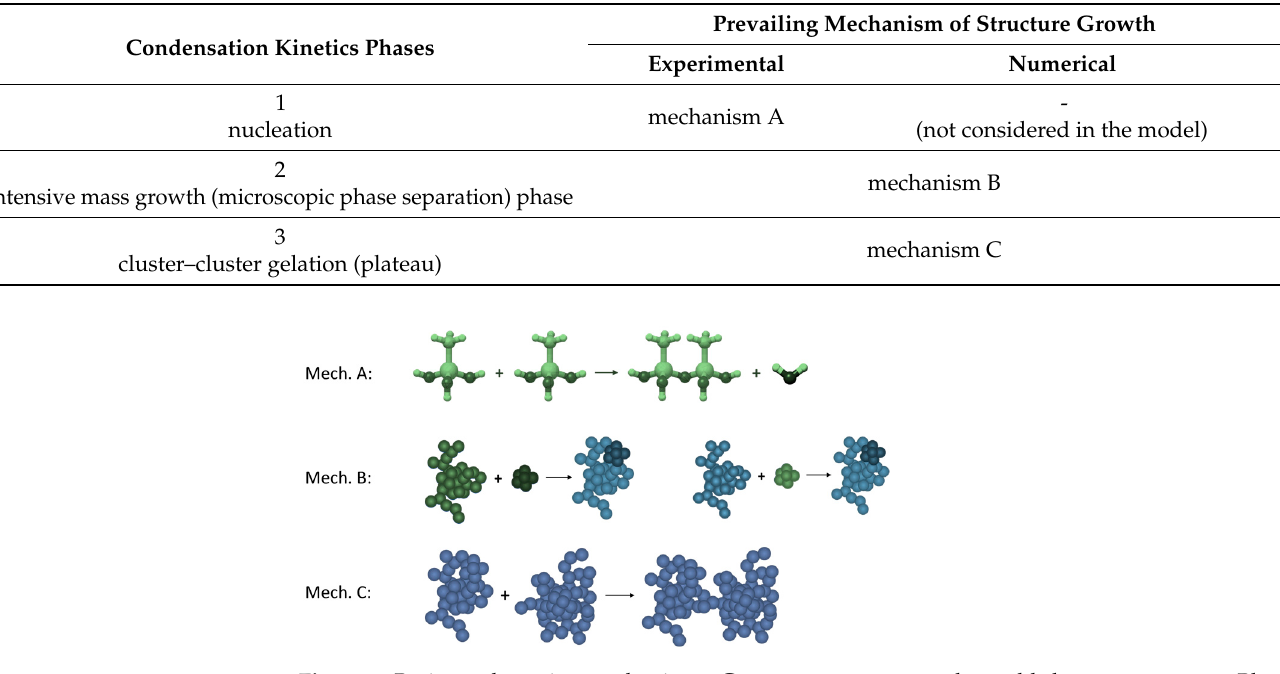
Figure 5. Basic condensation mechanisms. Green structures are undetectable by measurements. Blue structures are big enough to be registered. Table 2. Condensation kinetics phases and mechanisms (experimental vs. numerical designation) .